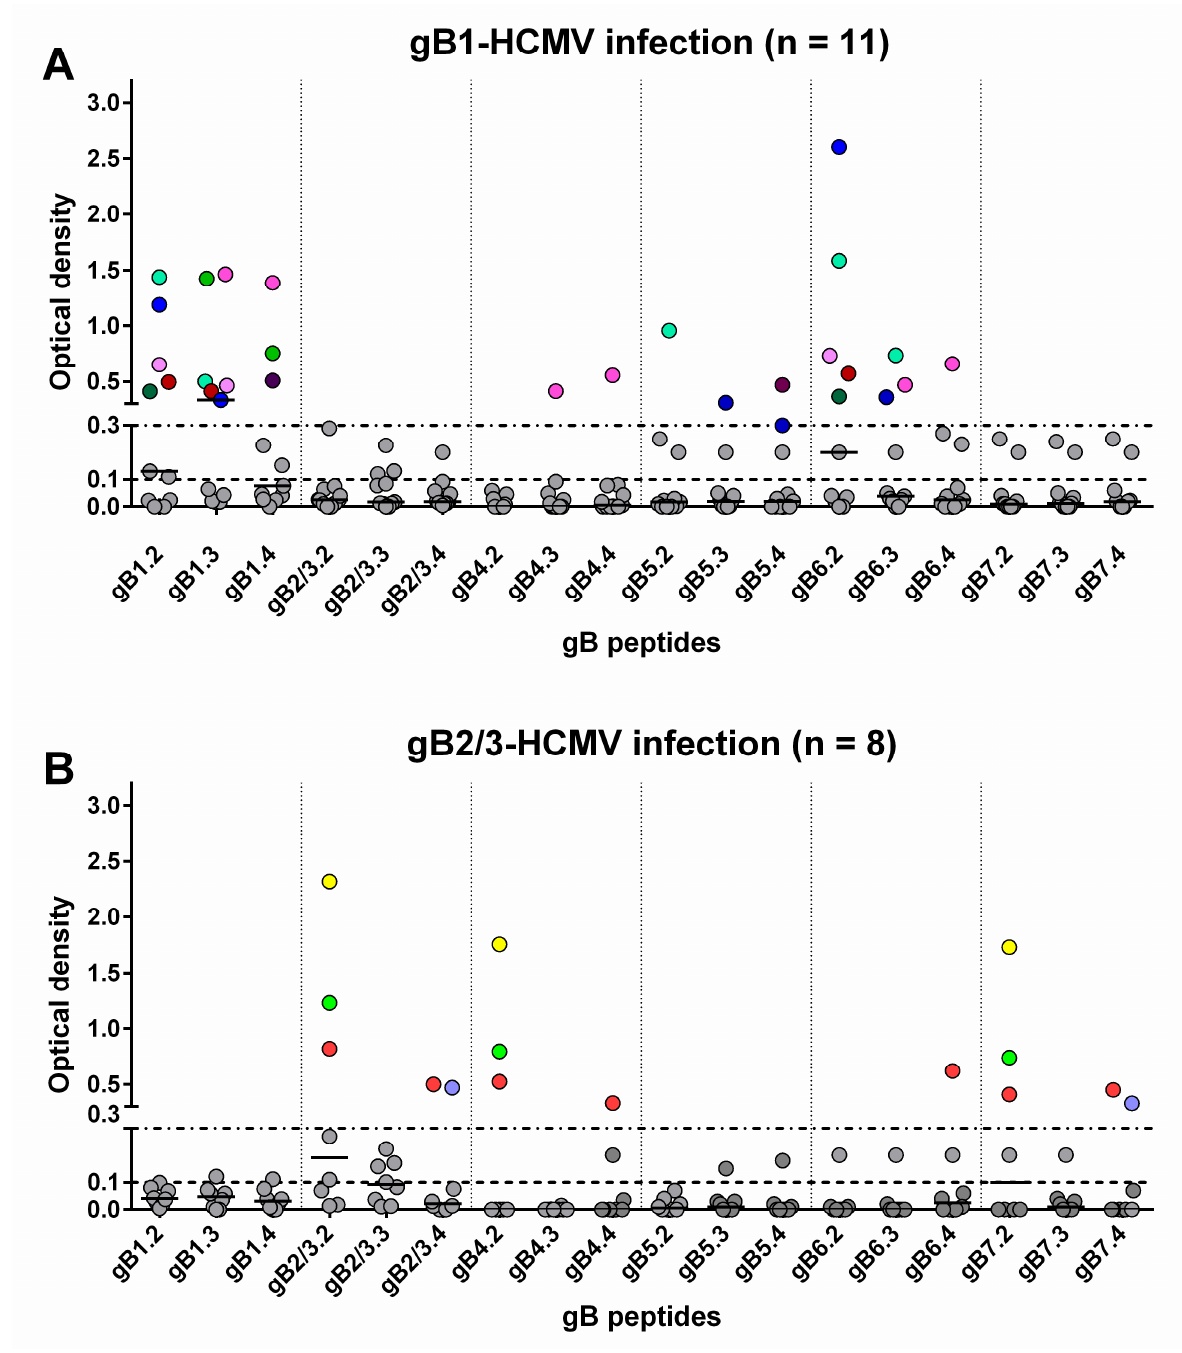
Figure 3. Genotype-specific IgG antibody (OD value) to peptides of the seven gB genotypes 1 year after primary HCMV infection. Each subject is represented by points in the same color above an OD value of 0.3. ( A ) IgG reactivity in subjects infected by gB1-HCMV. ( B ) IgG reactivity in subjects infected by gB2/3-HCMV.